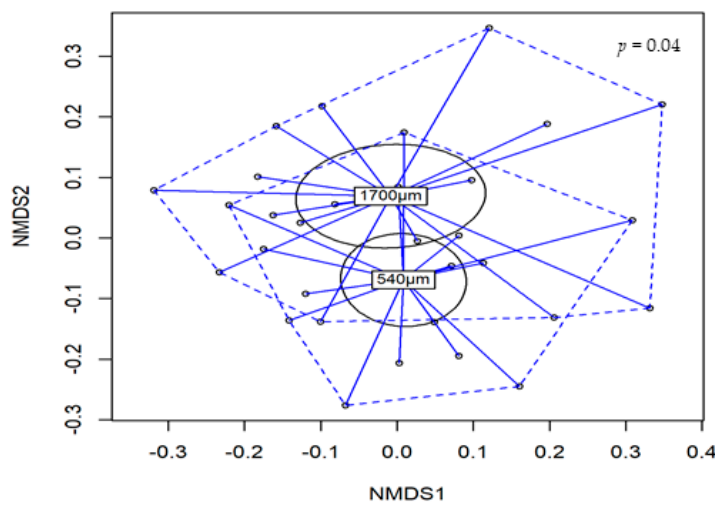
Figure 4. Comparison of beta-diversity of caecum microbiota between 540 and 1700 µm D gw corn diets. The nonmetric-multidimensional scaling (NMDS) plots was generated using Bray-Curtis distances. p- value was obtained from adonis